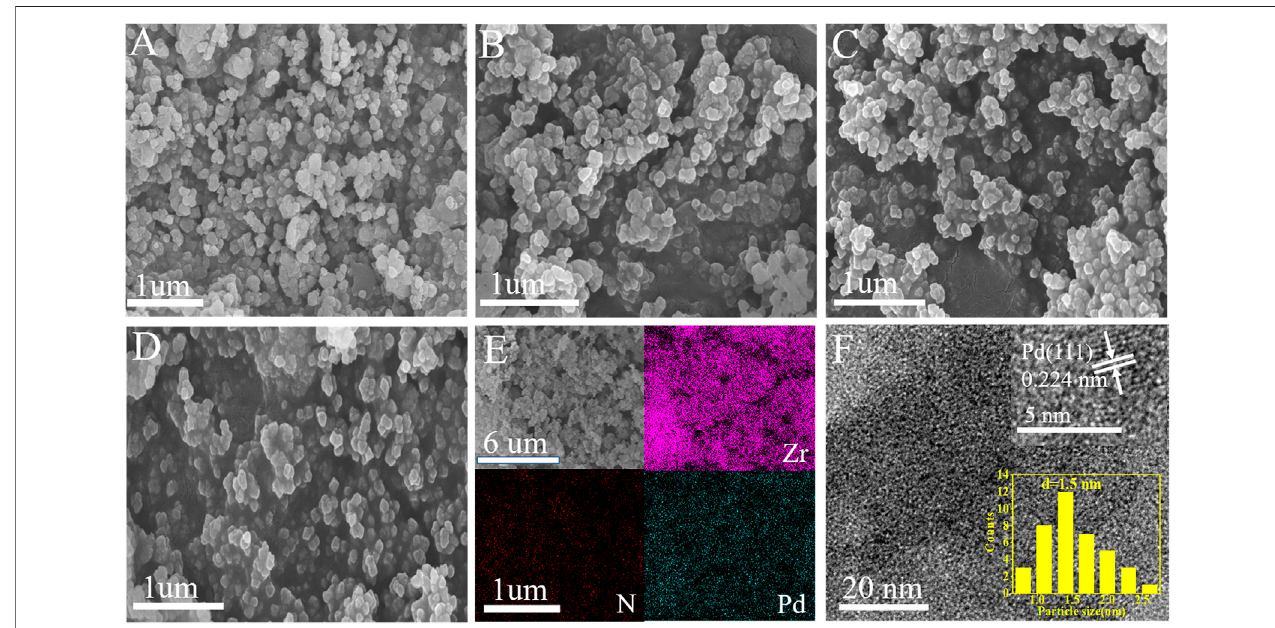
FIGURE 2 | Scanning electron microscopy (SEM) images of (A) UIO-66 – NH 2 , (B) UIO-66 – SB – Im, (C) Pd 2+ @UIO-66 – SB – Im, (D) Pd 0 @UIO-66 – SB – Im, (E) EDS mapping images for elements Zr, N, Pd elements of Pd 2+ @UIO-66 – SB – Im, transmission electron microscopy (TEM) images of (F) Pd 0 @UIO-66 – SB – Im.